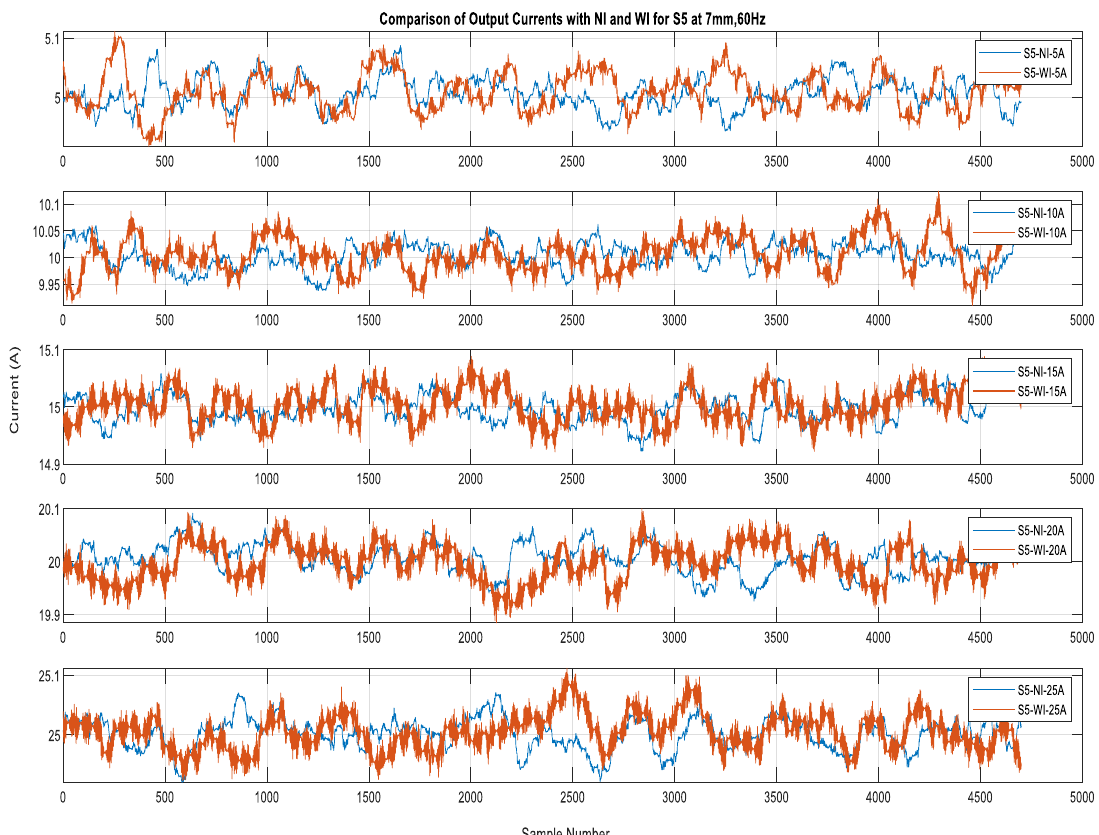
Figure 12. Sensor S5 outputs for currents of 5 A to 25 A: WI and NI cases.